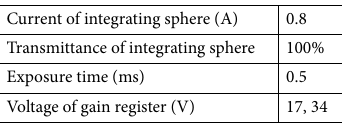
Table 2. EMCCD working parameters.